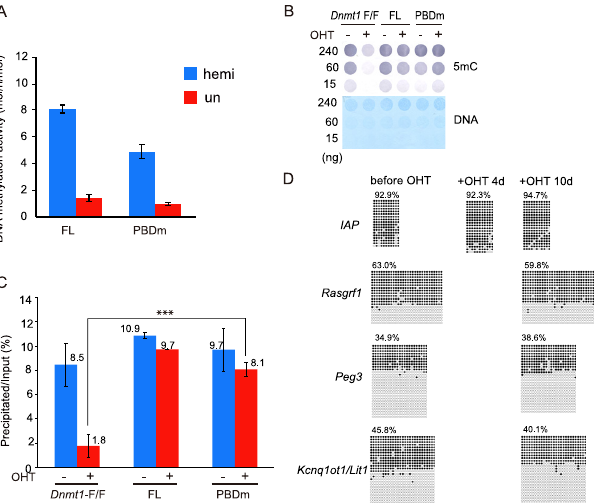
Fig 5. DNA methylation of ESC expressing full-length Dnmt1 with a mutation in the PBD. ( A ) DNA methylation activity of the recombinant full-length Dnmt1 (FL) and that with the H168R mutation (PBDm) was determined. The specific activities (mol/h/mol Dnmt1) towards hemi-methylated (hm) and un-methylated (um) DNA are shown as averages ± S. D. (n = 3). ( B ) Genome DNA prepared from the cells before and after deletion of the endogenous Dnmt1 gene with OHT for ten days was immuno-blotted with anti-methylated cytosine antibody (5mC, upper panel) or stained with methylene blue (DNA, lower panel). The amounts of DNA are shown at the left. ( C ) Genome DNA prepared as in B was sonicated and precipitated with MBD1, and then quantitated, averages ± S. D. (n = 3) being shown as in Fig 1D. The values for the parent genome before and after the OHT-treatment were taken from Fig 1D. *** , P < 0.001. ( D ) Genome DNA prepared as in B was analyzed as to the methylation state at the IAP and DMR of three imprinted genes, Rasgrf1 , Peg3 ,